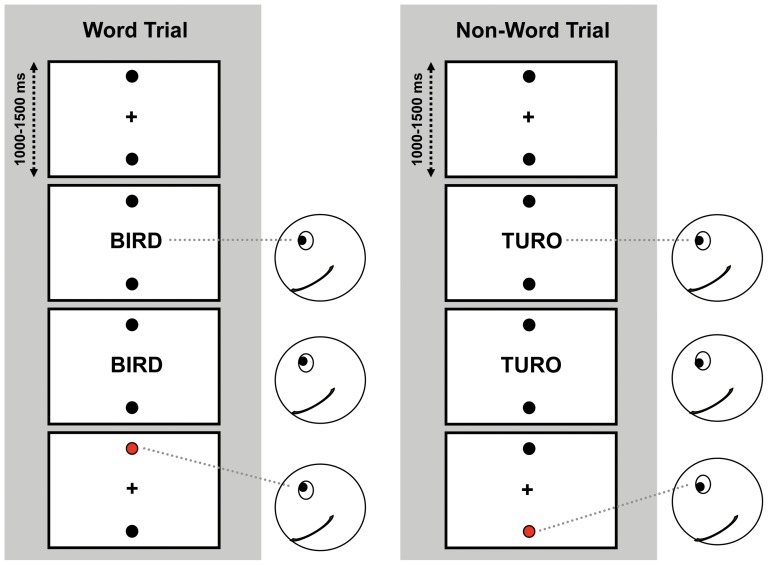
Exemplary trial procedure for a word (left panel) and a non-word trial (right panel).Participants responded in the first half of the experiment to indicate that a word is presented by looking upward (downward) and to indicate that a non-word is presented by looking downward (upward). In the second half of the experiment this mapping was reversed.